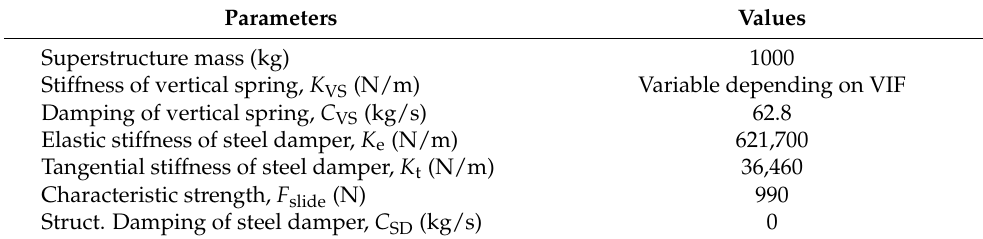
Table 3. Preliminary design parameter values for sensitivity analysis.